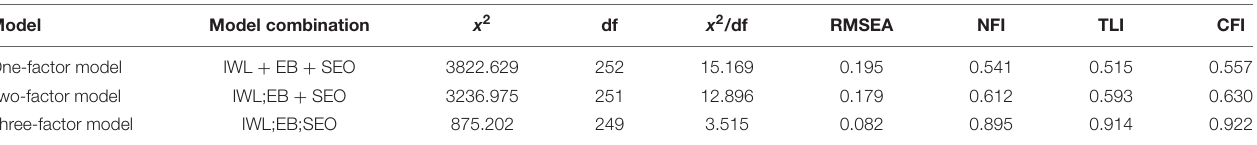
TABLE 3 | Results of confirmatory factor